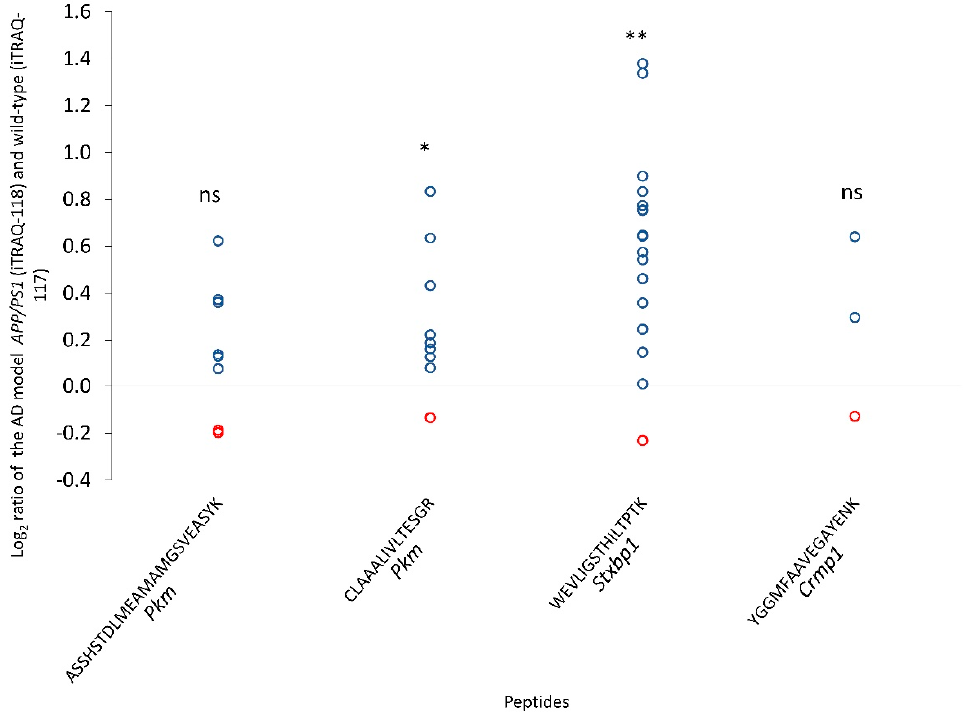
Figure 5. RNA-Seq expression levels for the orthologous alternatively spliced proteoforms selected for mRNA experimental validation. ( A ) Comparative analysis of transcript expression levels in tran- scripts per million (TPM) across the corpus callosum and olfactory bulb in mice and humans. The Y-axis shows the expression of transcripts in TPM, and the X-axis shows the different transcripts. ( B ) Transcript expression levels (2 −∆∆ Ct ) of the AS variants of the genes Cadm1, Crmpd1, Hnrnpk, Pkm, Prkcb, and Stxbp in the mouse CC and OB. Two-sample t-test; p -value ≤ 0.05 (*) and p -value ≤ 0.01 (**).